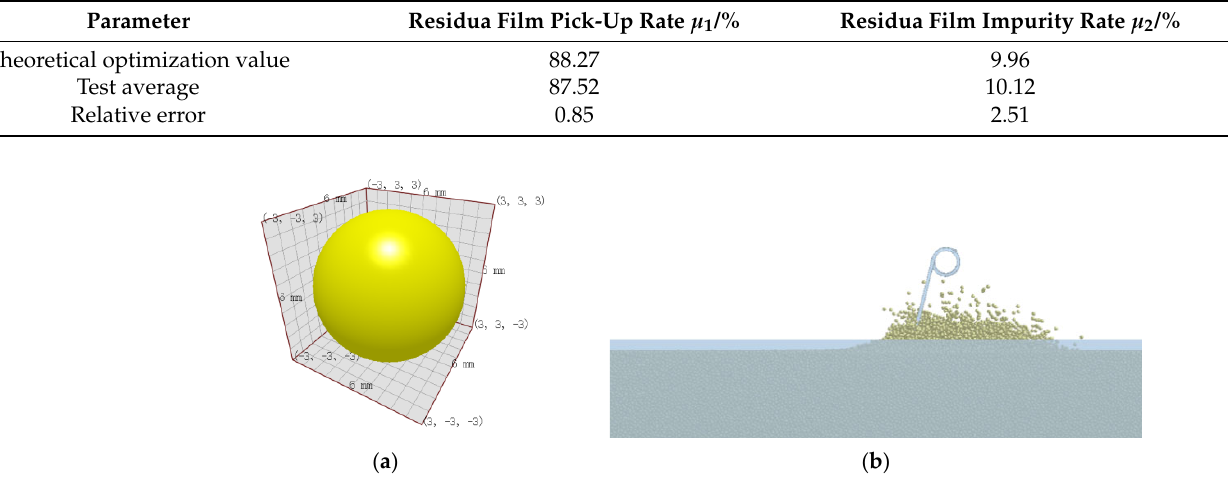
Table 6. The simulation parameter settings of soil particles and geometry.